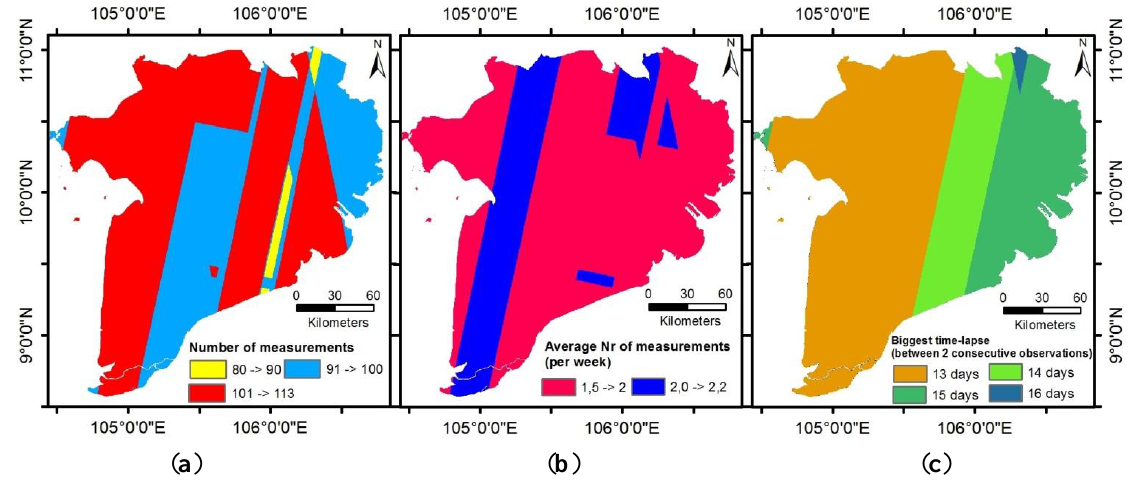
Figure 3. ( a ) Temporal and spatial distribution of available Envisat ASAR WSM scenes. ( b ) Average number of measurements per week. ( c ) Largest interval between DOY of ASAR WSM acquisitions from 2007 to 2011.